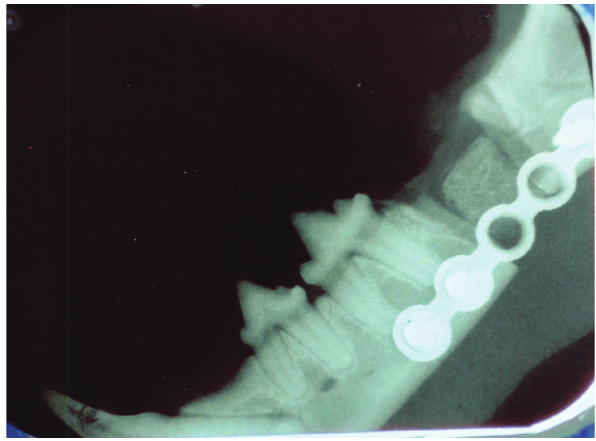
FIGURE 4 - Radiograph in ventrodorsal projection taken 1 week after surgery shows the segmental defect filled with autogenous bone graft. Cat 20 of Group 2.